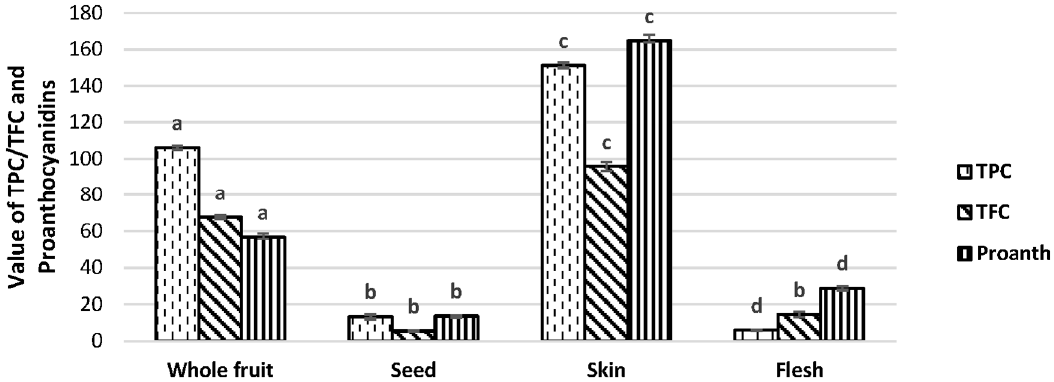
Figure 2. Phytochemical content of Tuckeroo whole fruits and its components. The vertical bars represent standard deviation ( n = 3). Different superscript letters on top of each type of column indicate significant differences ( p < 0.05).